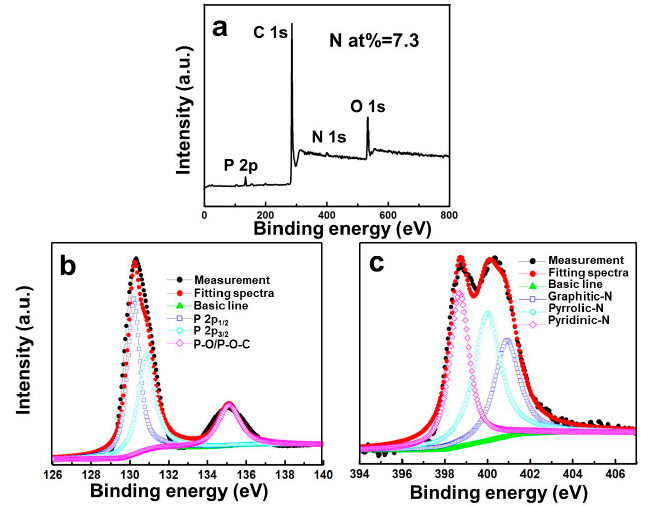
Figure 3. ( a ) X-ray photoelectron spectroscopy (XPS) survey spectra of RPNC; high-resolution XPS spectra of ( b ) P 2p and ( c ) N 1s in the RPNC.